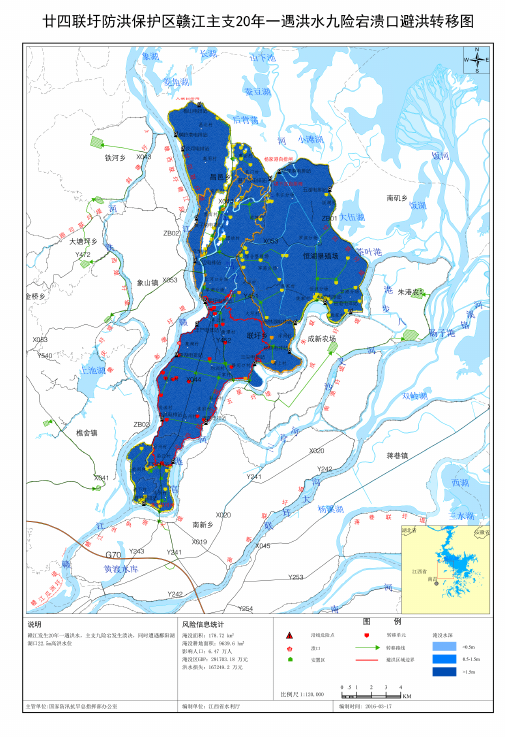
Figure 2. A typical flood evacuation map in China steps of flooding. In addition, new queries such as flood situ- ation around certain objects can also be resolved. Hence, to address issues listed above, developing an efficient database for ad-hoc queries is